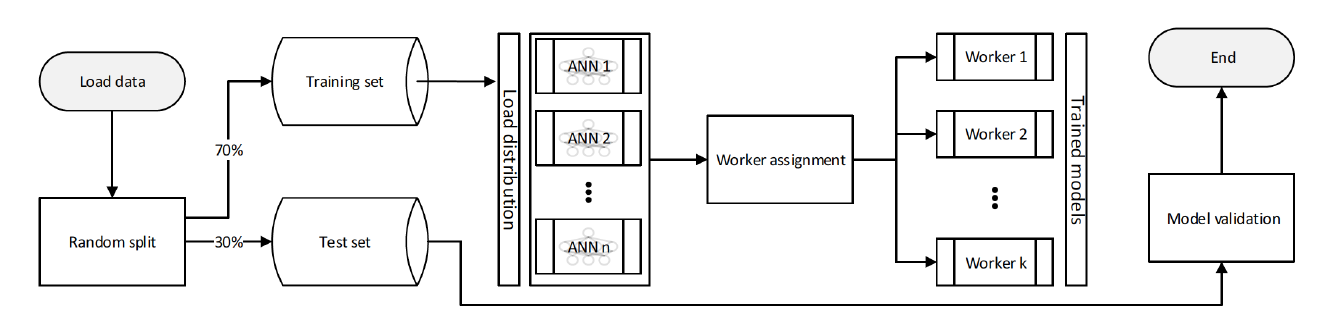
Figure 5. Division of tasks for the specific models’ training process that form the global model.